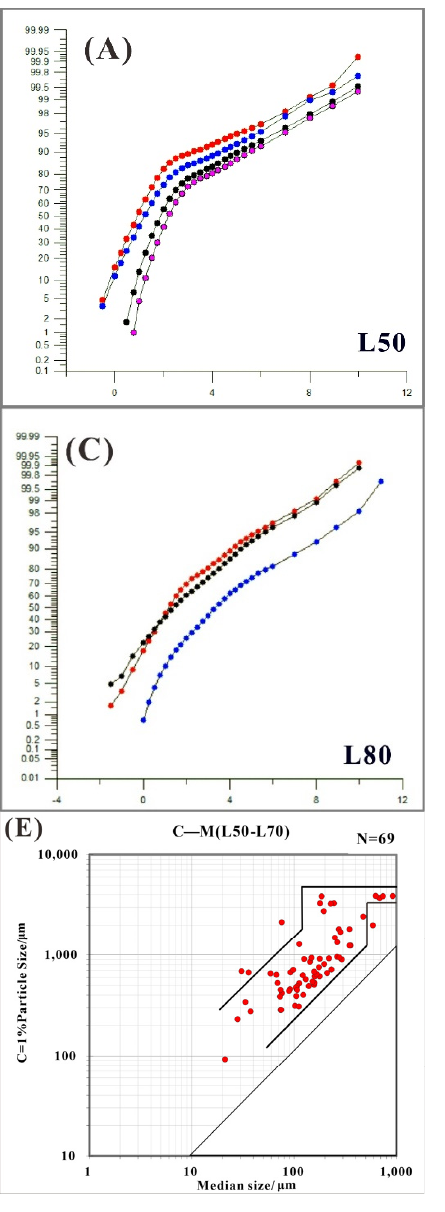
cumulative grain size curves of the PL19 − 3 − A well. ( B ) The probability